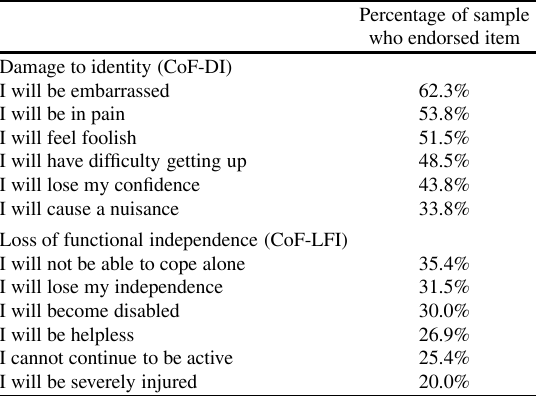
Table 1A Consequence of Falling scale. Percentage of the sample who agreed or strongly agreed with each item. “I think that if I fall over . .. ”. Valid N ranged from 116 to